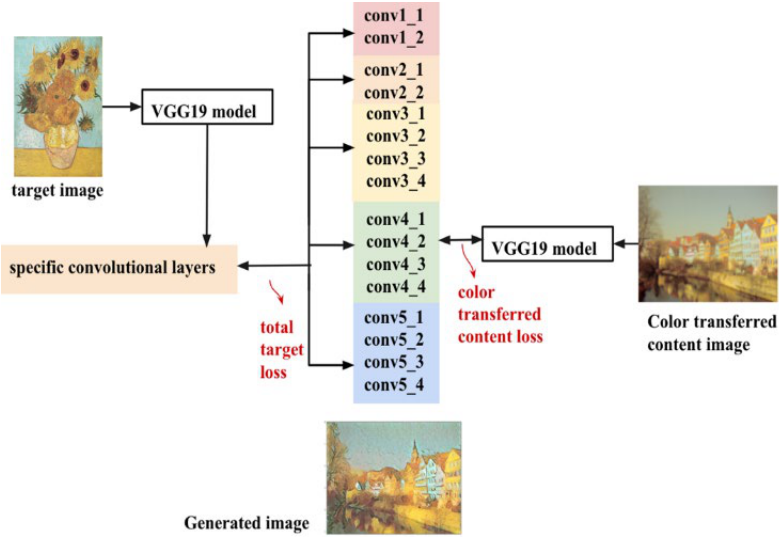
Figure 9. The image style transfer process.